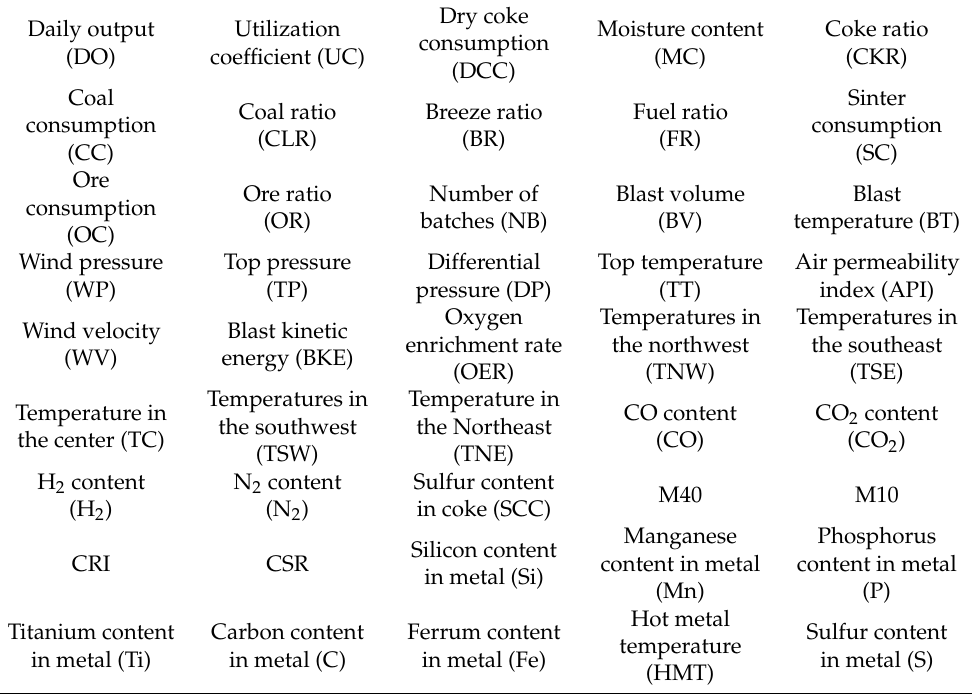
Table 1. The parameters and abbreviations collected in this